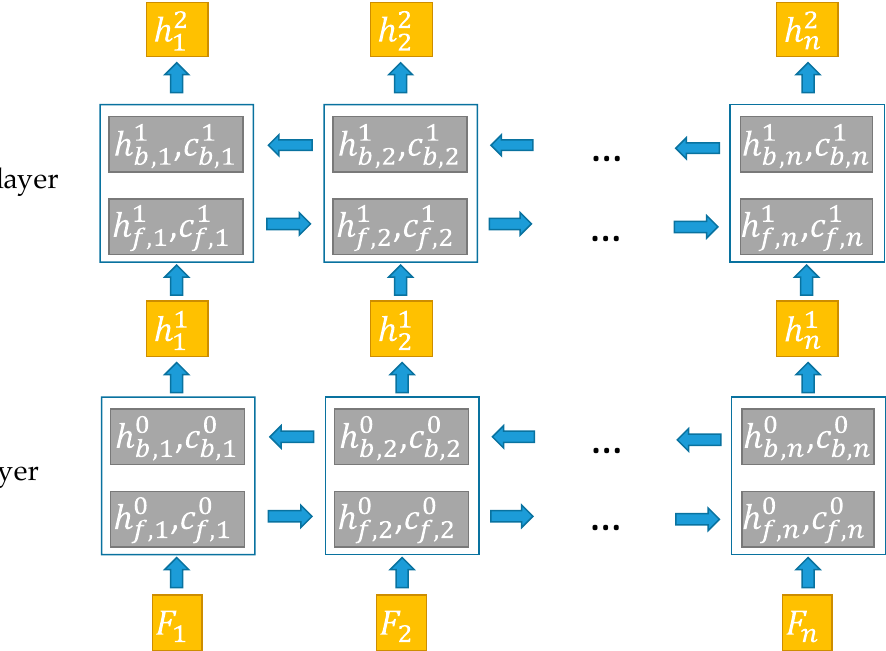
Figure 6. The structure of our BiConvLSTM layers. We concatenated all previous recursions [ F n , F n − 1 , ... , F 1 ] in the order of the sequence as a temporal sequence. h 1 ∗ and h 2 ∗ denote the middle stage of the first hidden layer and the second layer, respectively, extracted from the forward and the backward ConvLSTM layer hidden states h i and h i f , ∗ b , ∗ .